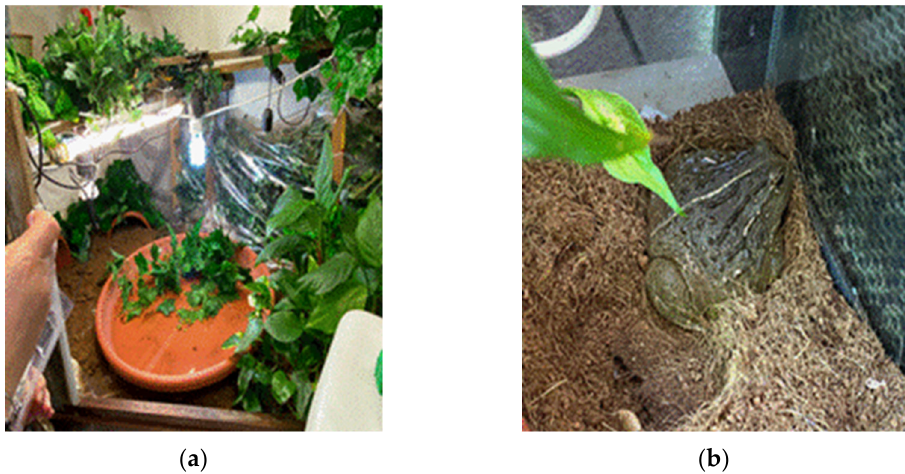
Figure 2. Environment housing adult bullfrogs: Terrarium equipped with a wet area ( a ) and a dry area ( b ) consisting of coconut fibre bedding and environmental enrichment (plants and